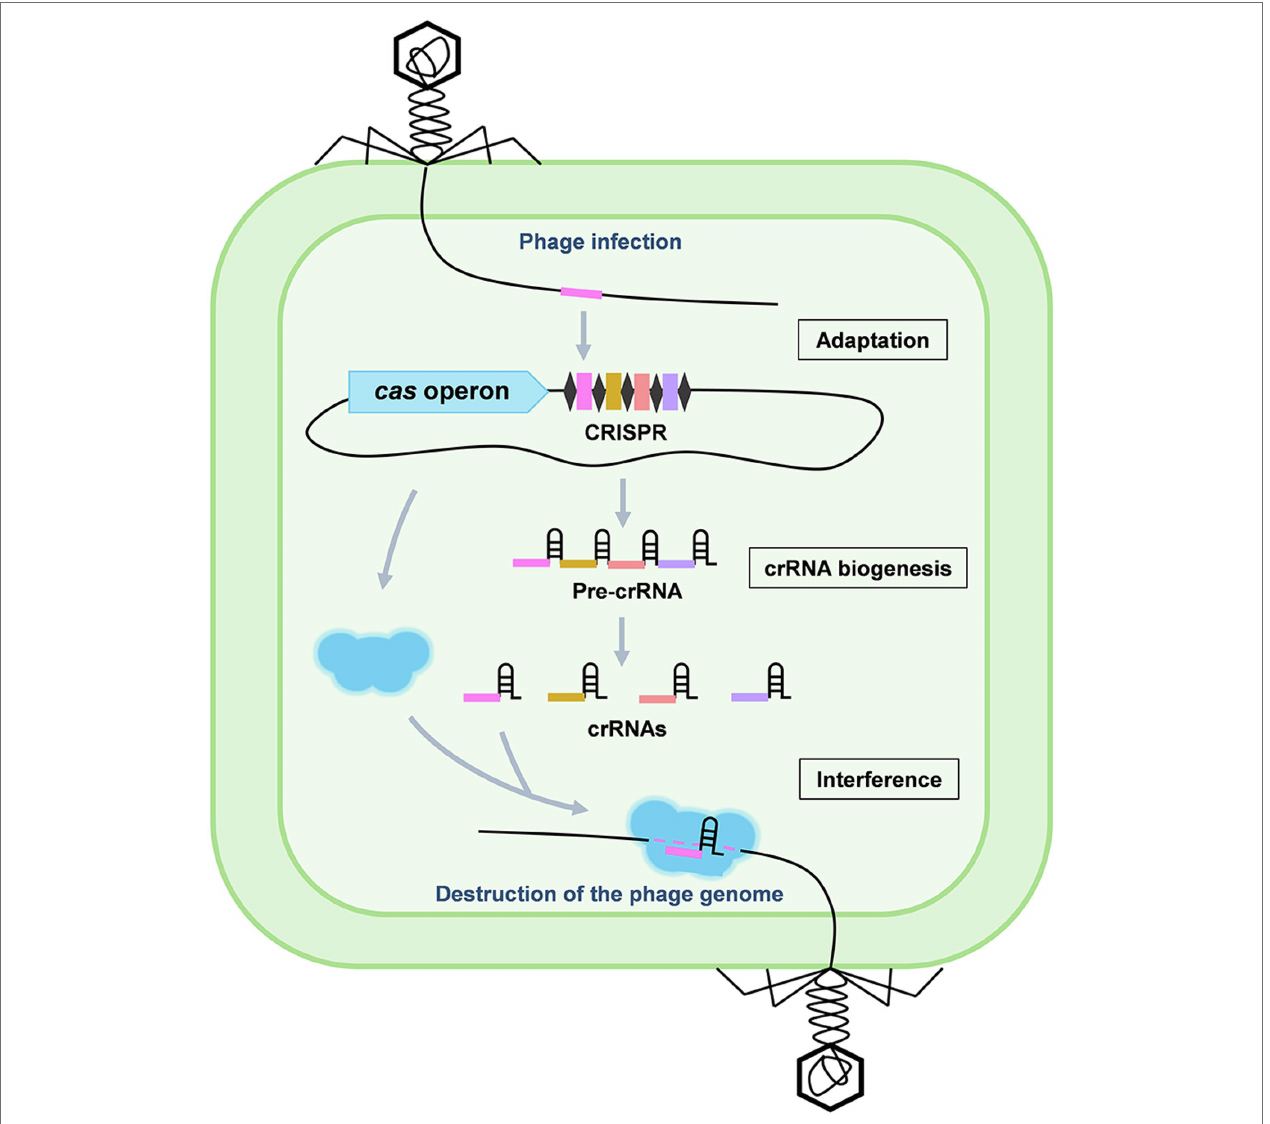
FIGURE 1 | Stages of the CRISPR-Cas adaptive immunity. CRISPR-Cas immunity consists of three stages: adaptation, crRNA biogenesis, and interference. During adaptation, a DNA fragment of the invading genetic elements, such as a phage genome, is captured and incorporated into the CRISPR array to generate a new spacer (pink). During crRNA biogenesis, the entire CRISPR array is transcribed into a long pre-crRNA which is further processed into mature crRNAs. During interference, the crRNA specifically recognizes a target protospacer sequence in the invaders by base pairing and guides the Cas effector to destruct the